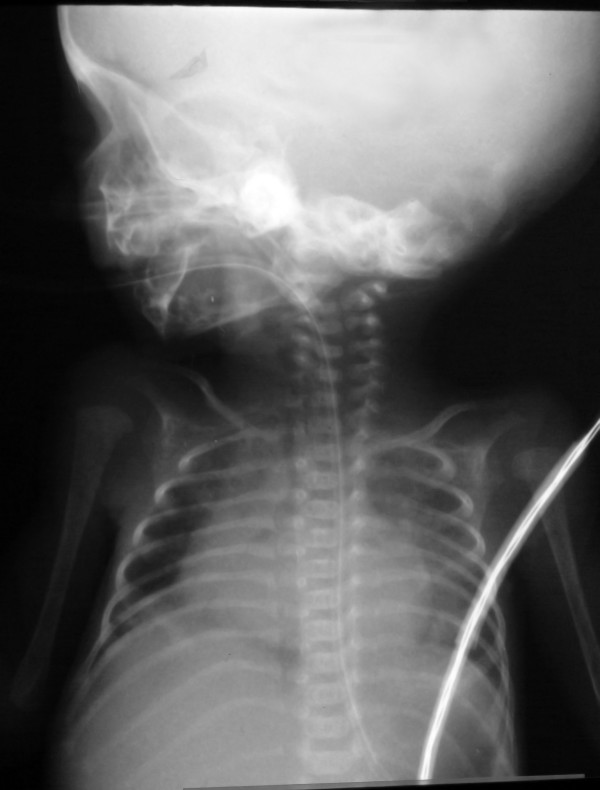
X-ray chest with mandible showed calcified crowns of the first and second deciduous molar in Twin B.